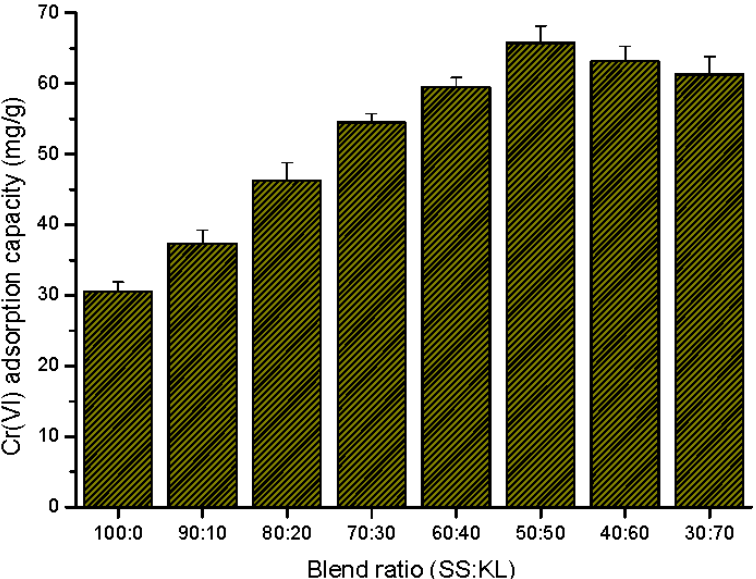
Figure 7. Effect of the SS/KL blend ratio on the Cr(VI) adsorption capacity of SS/KL beads.